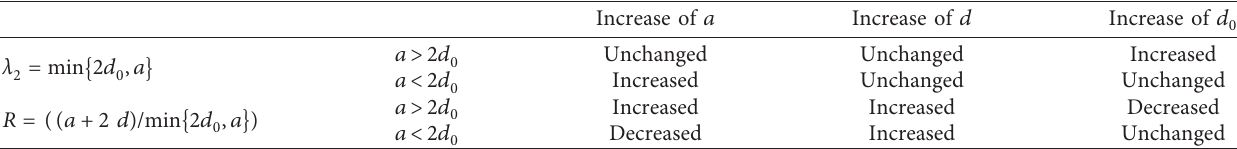
and R with the increase of a,d, and d 2